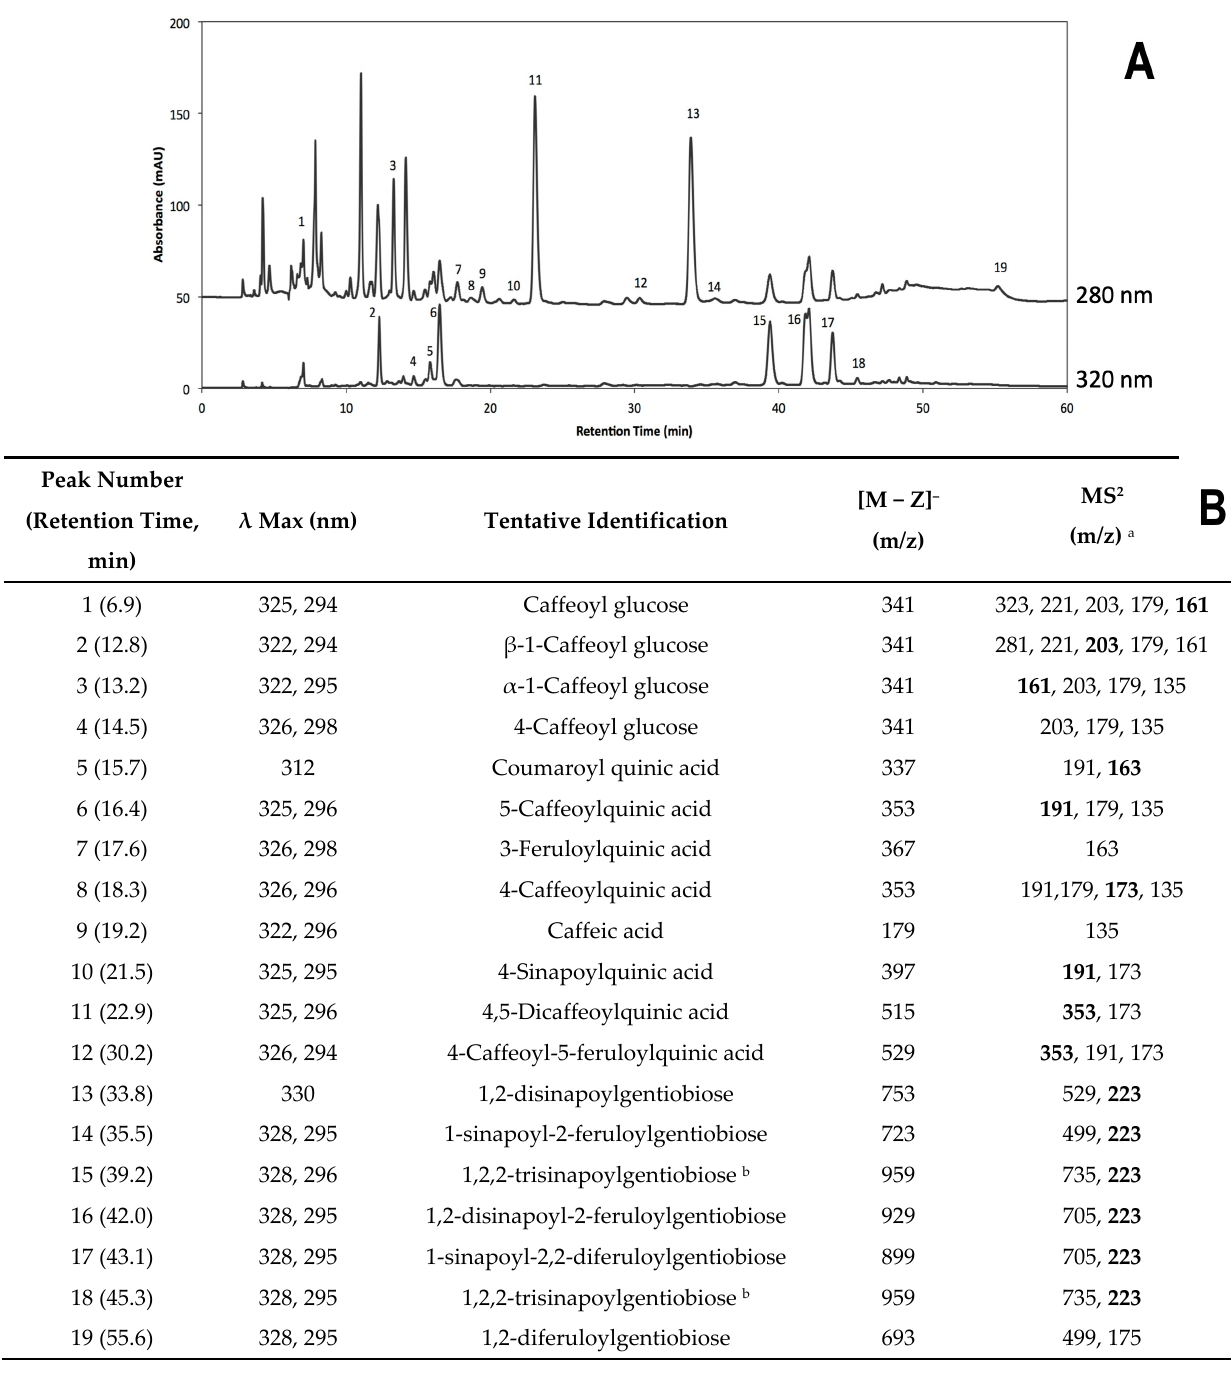
Figure 3. Typical HPLC-DAD chromatogram of phenolic compounds (( A ), shown at 280 and 320 nm) obtained from methanol/water (70/30, v / v ) extracts in broccoli. Identification of individual phenolics was achieved using HPLC-DAD and HPLC-ESI-MSn ( B ). a Major fragmentations are highlighted in bold. b Isomeric